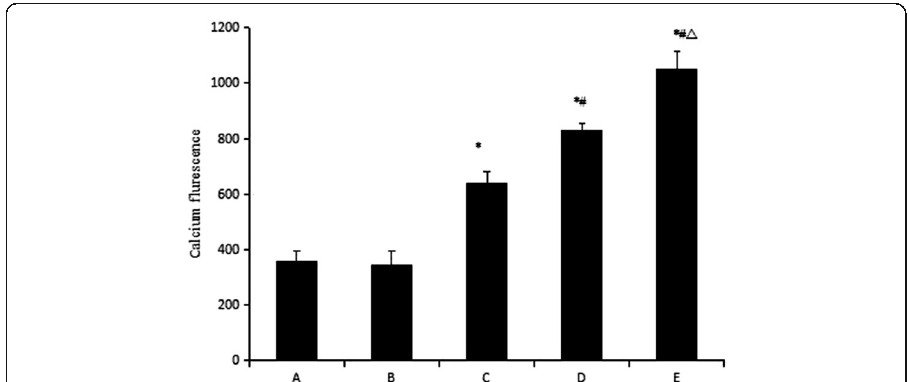
dose calcium ionophore A23187 groups were 0.48 ± 0.03, 0.66 ± 0.06 and 0.90 ± 0.03, respectively. As the dose of A23187 increased, the expression of C-caspase-12 protein also increased in the groups, and the differences between the two were statistically sig- nificant ( p < 0.05). Protein gel electrophoresis of C-caspase-9 expression in the different treatment groups of HSCs is shown in Fig. 6. The mean grey values of C-caspase-9 protein for the blank group and the TGF- β group were 0.34 ± 0.05 and 0.30 ± 0.02, respectively. 1 The difference was not statistically significant ( p > 0.05). The mean grey values of the low, middle and high dose calcium ionophore A23187 groups were 0.62 ± 0.06, 0.85 ± 0.08 and 1.21 ± 0.21, respectively. As the dose of A23187 increased, the expression of